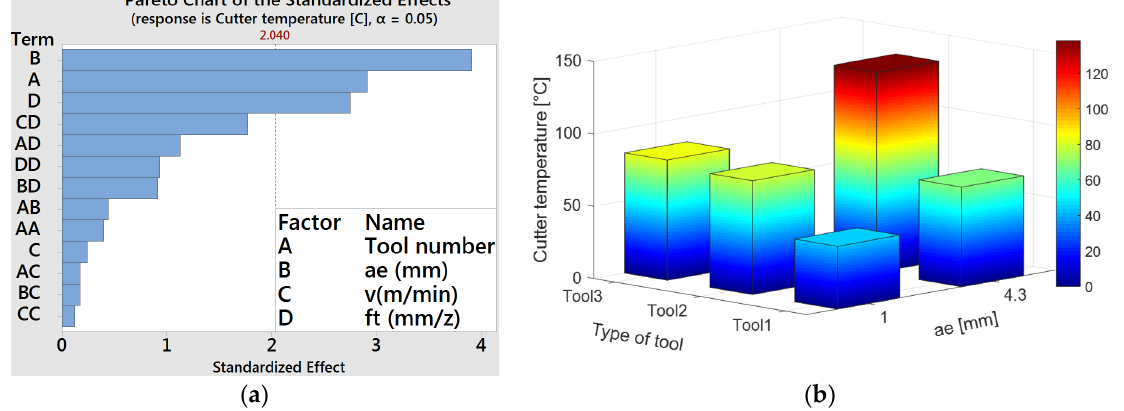
Figure 16. ( a ) Pareto chart of the standardized effects; ( b ) 3D bar effect graph for the cutter temperature for an ft of 0.05 mm/tooth, v of 175 m/min.